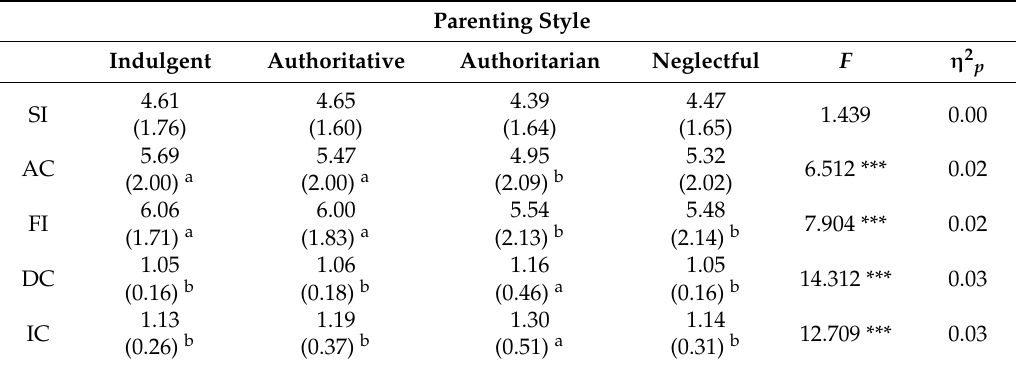
Table 3. Means (Standard deviations), F values, and Bonferroni post hoc test for the parenting style groups across